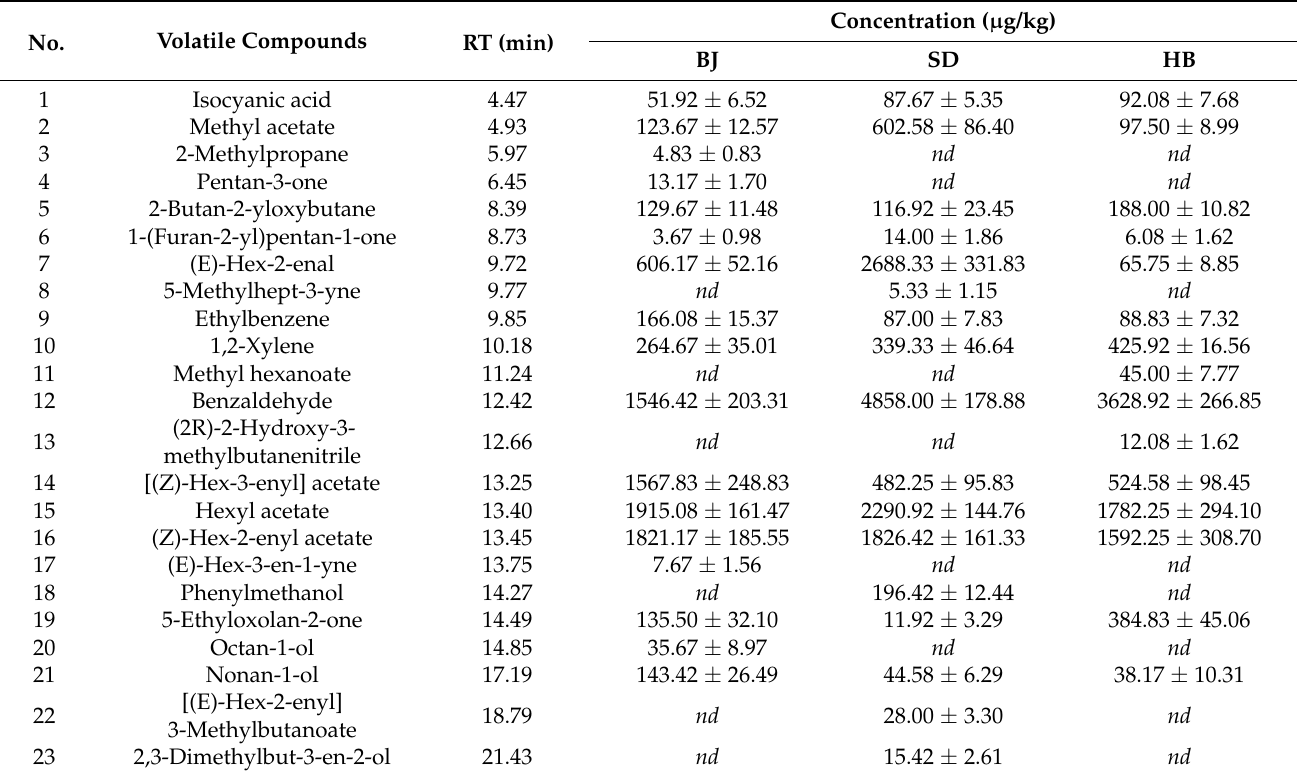
Table 1. The volatile compounds of peach from three cultivation regions of BJ, SD, and HB. nd represents not